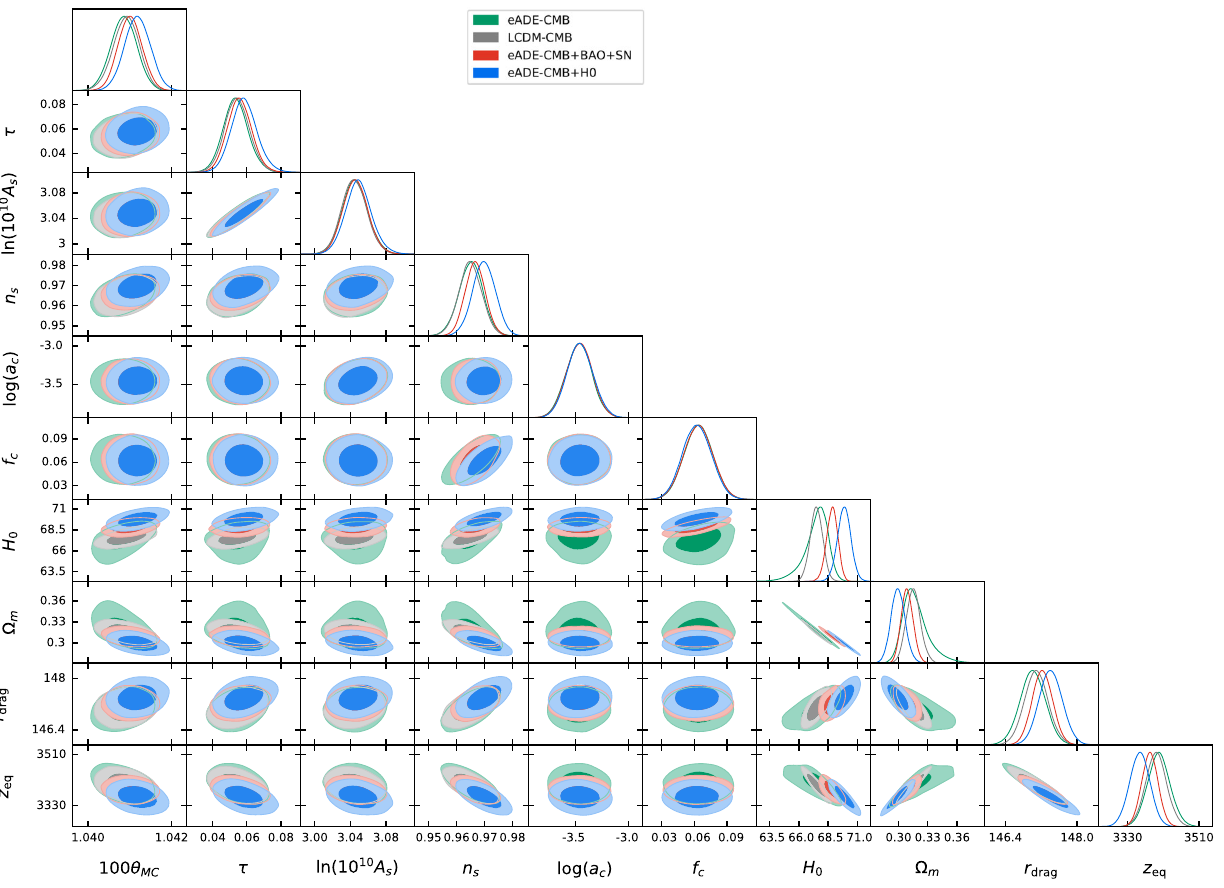
Fig. 2 One and two-dimensional distributions of parameters in eADE model and (cid:2) CDM, where the contour lines represent 68% and 95% CL, respectively